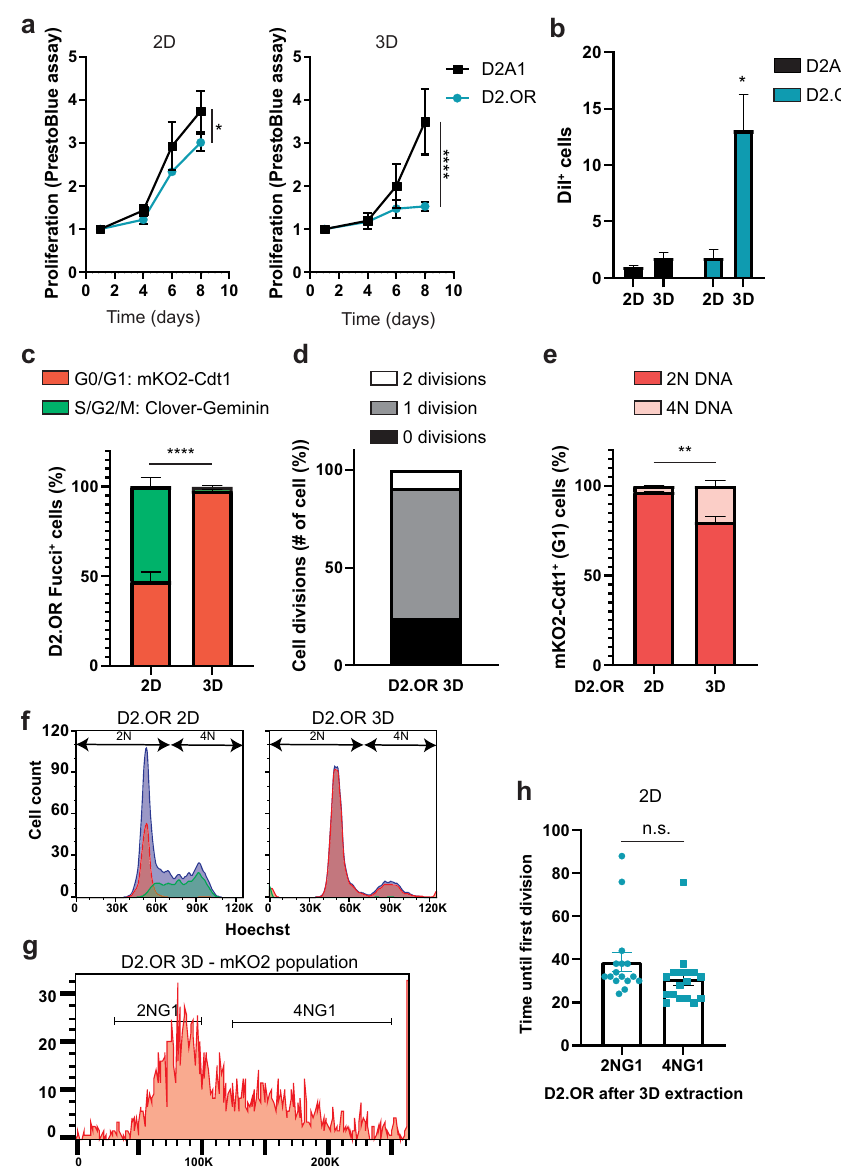
Fig. 2 Characterization of D2.OR G1 cell cycle arrest in 3D culture. a Proliferation analysis of D2A1 and D2.OR cells in 2D or 3D culture conditions using PrestoBlue cell viability assay. N = 3 replicates in duplo/triplo. 2D graph: interaction effect, F (3,42) = 3.685, P = *. 3D graph: interaction effect, F (3,42) = 10.57, P = ****. b Quanti fi cation of the percentage of DiI + cells after eight days of culture by FACS. N = 3 repeats. Interaction effect, F (1,6) = 6.278, P = *; post hoc test, D2OR 3D vs all others, P = *. c Quanti fi cation of the percentage of Fucci + cells (either Clover + or mKO2 + ) after three days of culture by FACS. N = 3 repeats. d Quanti fi cation of the number of cell divisions until cells remained in G1 (mKO2 + ) after plating in Matrigel. Cells were imaged every 3 h. N = 5 positions, 13 cells. e Quanti fi cation of FACS analysis showing the percentage of mKO2 + D2.OR Fucci + cells containing 2 N or 4 N DNA (measured by Hoechst) in 2D or 3D after three days of culture, N = 3. f FACS plot of experiment quanti fi ed in c and e . Blue: Hoechst, Green: Clover – Geminin, Red: mKO2 – Cdt1. g FACS plot of D2.OR-FUCCI4 cells incubated with Hoechst and extracted from 3D and sorted according to strategy as displayed in supplementary Fig. 6c. The mKO2 + cells are shown in a histogram with Hoechst (DNA) on the X axis to show the cell cycle pro fi le. Representative image from N = 3. h Quanti fi cation of the time until the fi rst division of sorted D2.OR cells extracted from 3D Matrigel. The population is based on gates shown in g . Quanti fi cation of a representative experiment of N = 3. P values were calculated using a repeated measures 2-way ANOVA or t -test. Error bars,